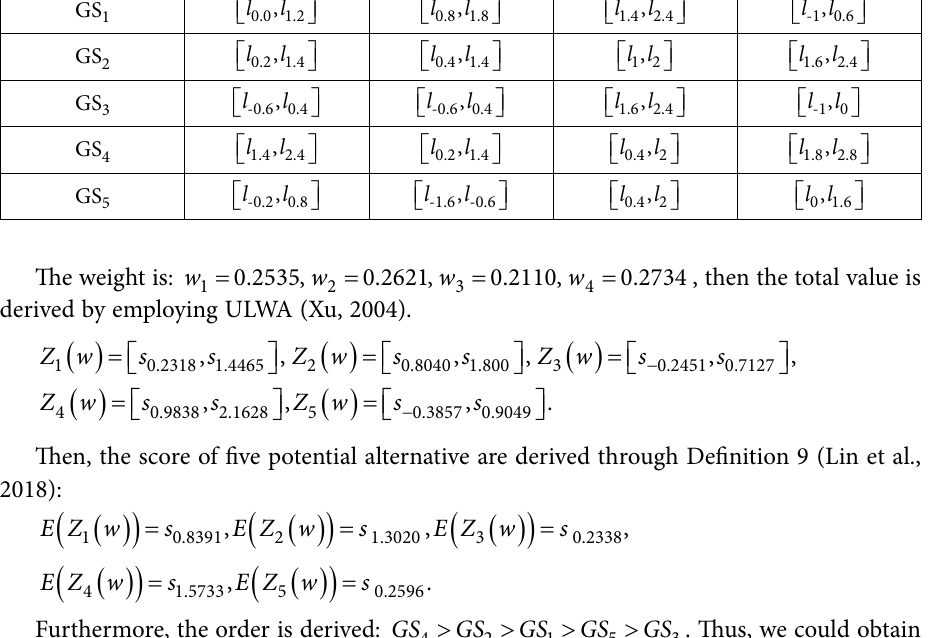
Table 18. Group uncertain linguistic matrix Alternatives